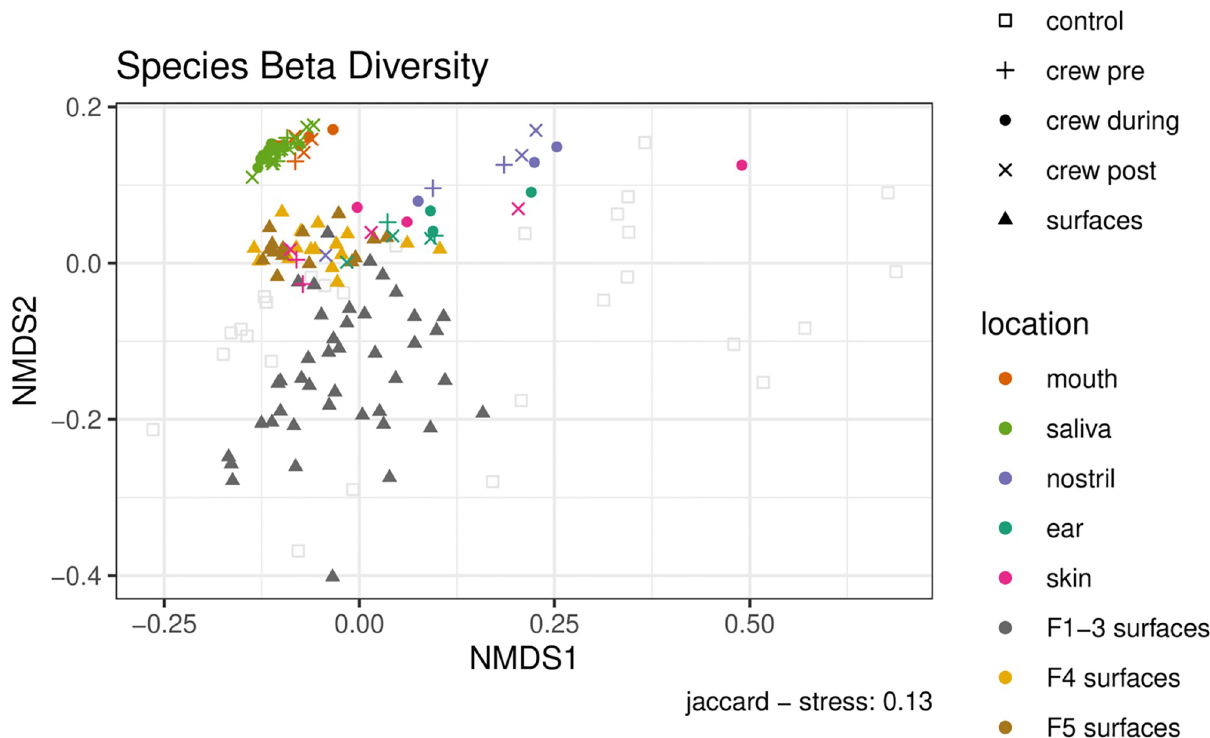
Fig 5. NMDS ordination of samples by Jaccard distance at species level resolution. Environmental samples are shown as gray circles (Flights 1–3 [2]) and brown and yellow circles (Flights 4, 5 this analysis). Samples from the crewmember (this analysis) are shown as circles for during flight, plus signs (+) for pre-flight, and crosses (x) for post-flight. Skin samples are colored pink; mouth as red, saliva lighter green, nostril purple, ear darker green. Control samples are semitransparent